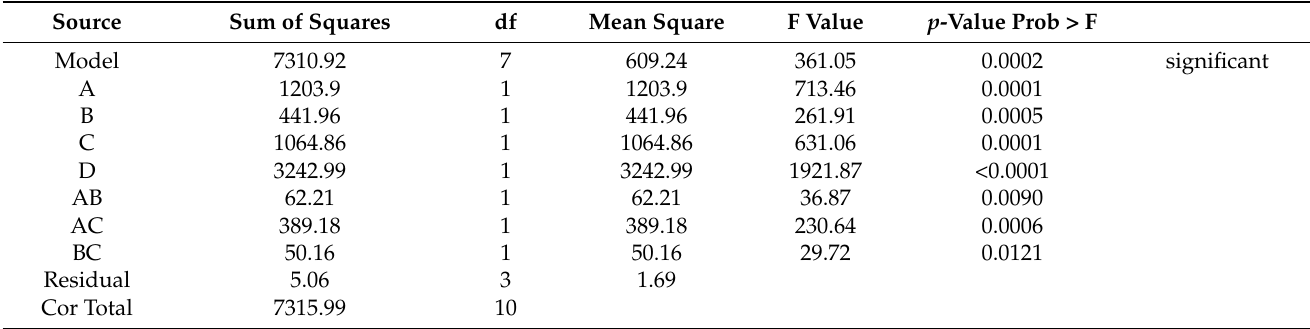
Table 8. Analysis of variance for PBV adsorption.